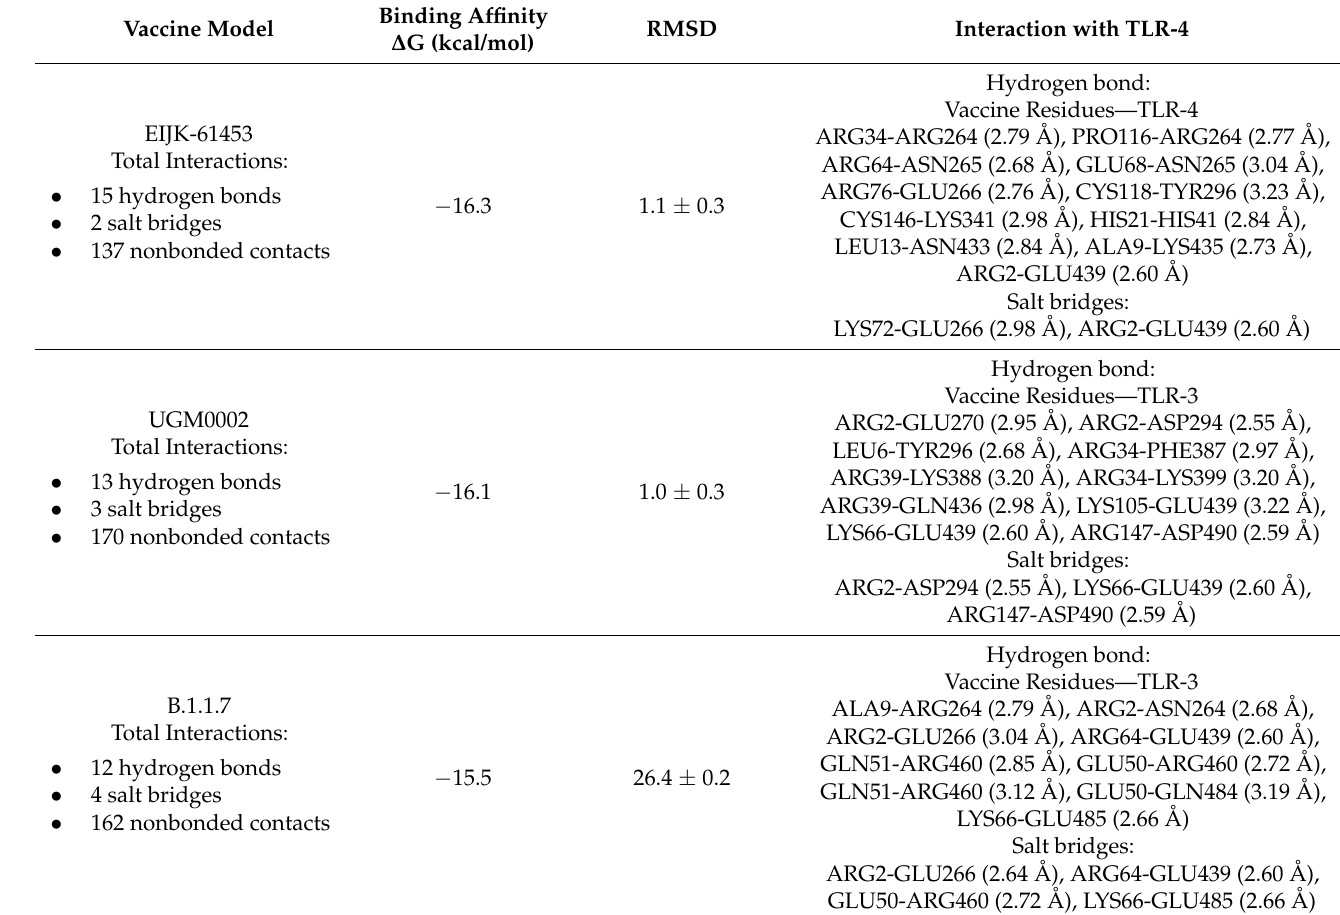
Table 8. The bond type and amino acid residues interacting between vaccine models and TLR-4.